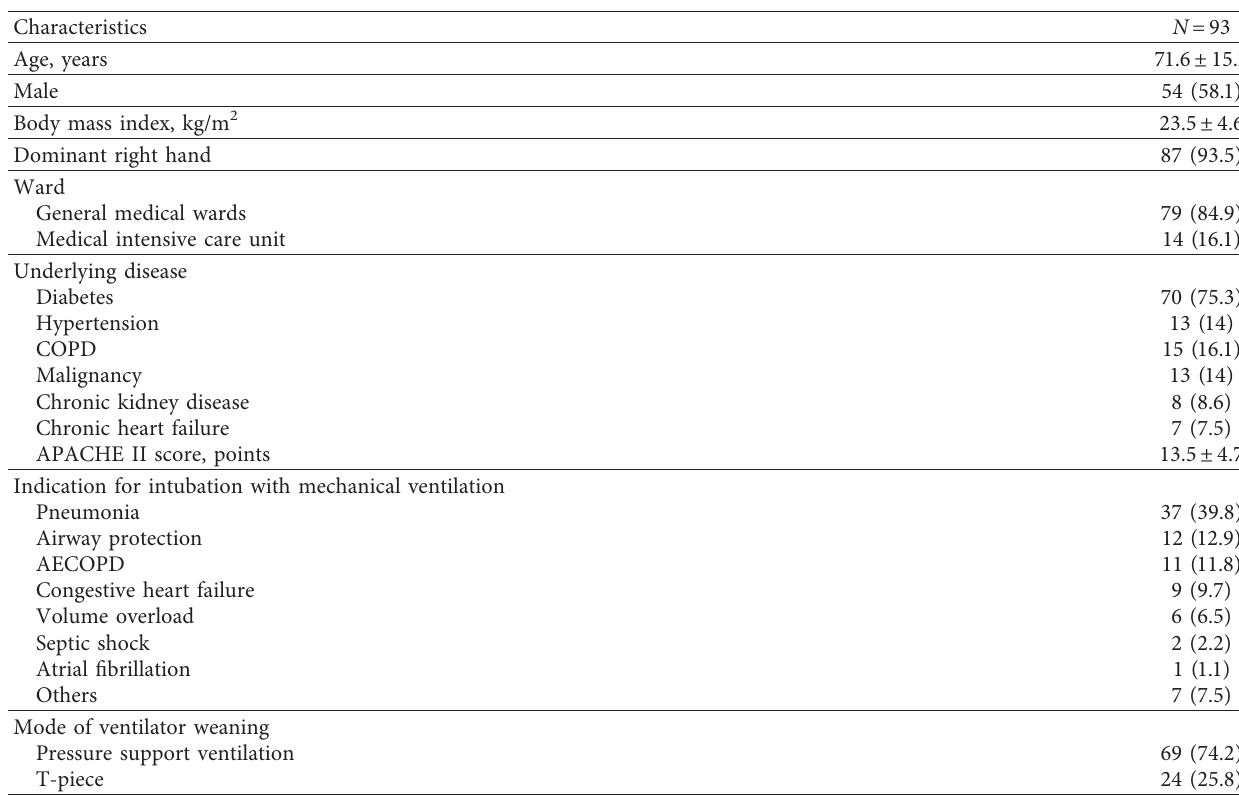
Figure 1: Study flowchart indicating inclusion and exclusion population. Table 1: Baseline